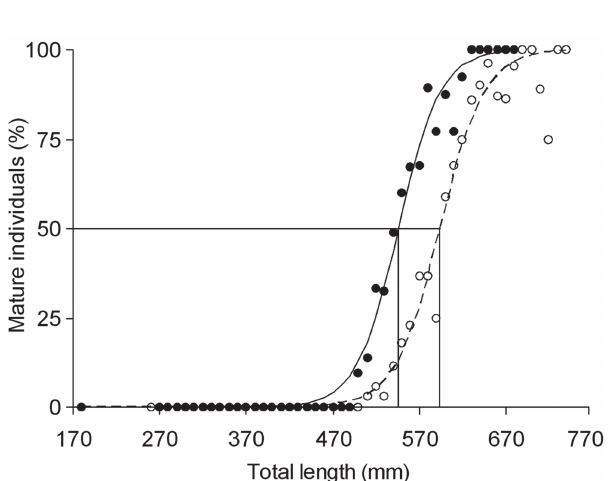
) of Sympterygia bonapartii 50% (–)= 50% (̵ ̵)= 594 50%